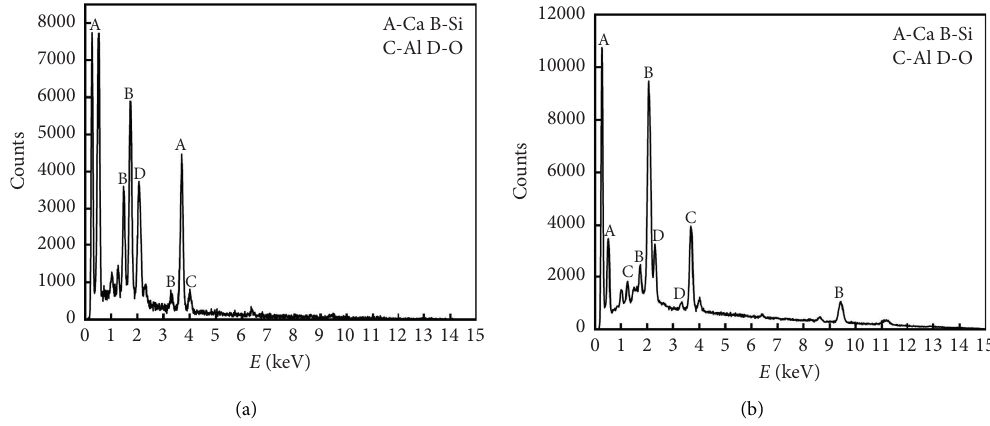
Figure 18: EDS test results. (a) OC group. (b) HC-0.2